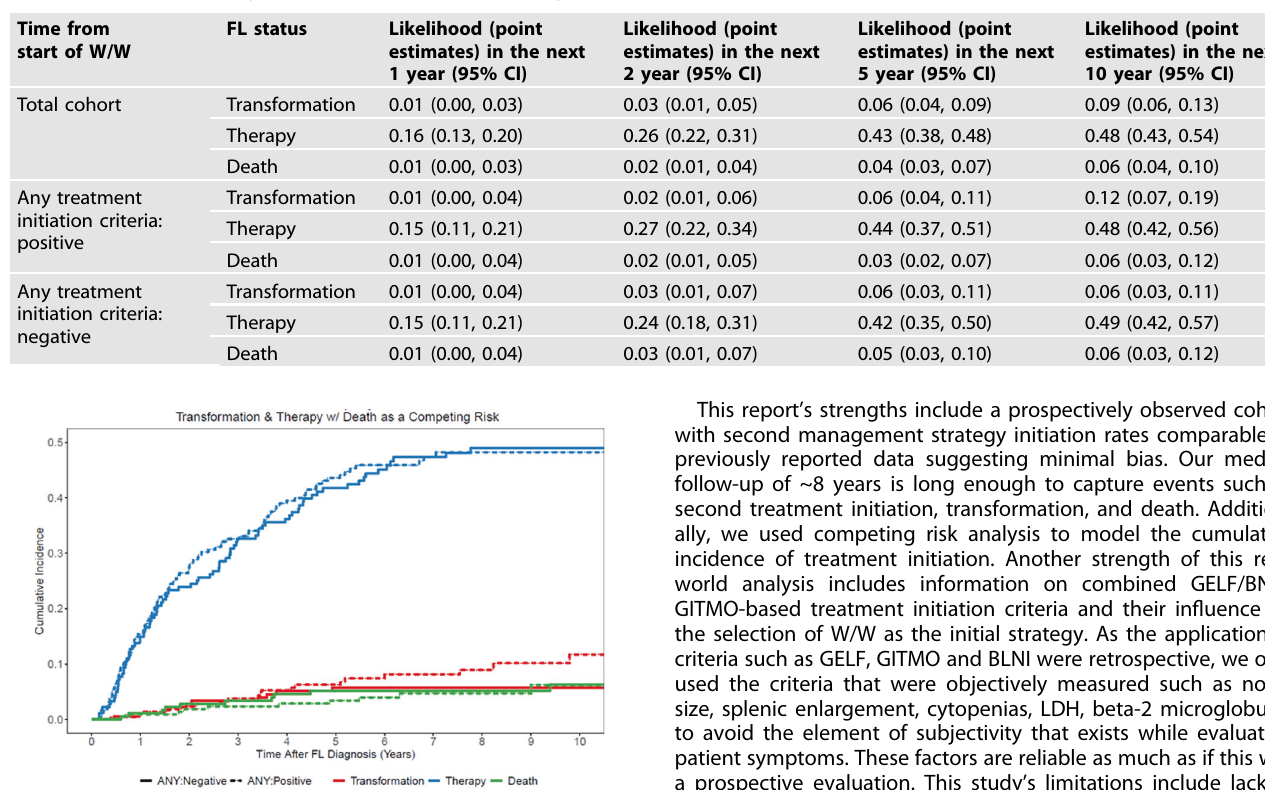
Table 4. Cumulative incidence estimates of treatment initiation, transformation to DLBCL before treatment, and death without therapy based on presence or absence of any treatment initiation criteria at diagnosis.